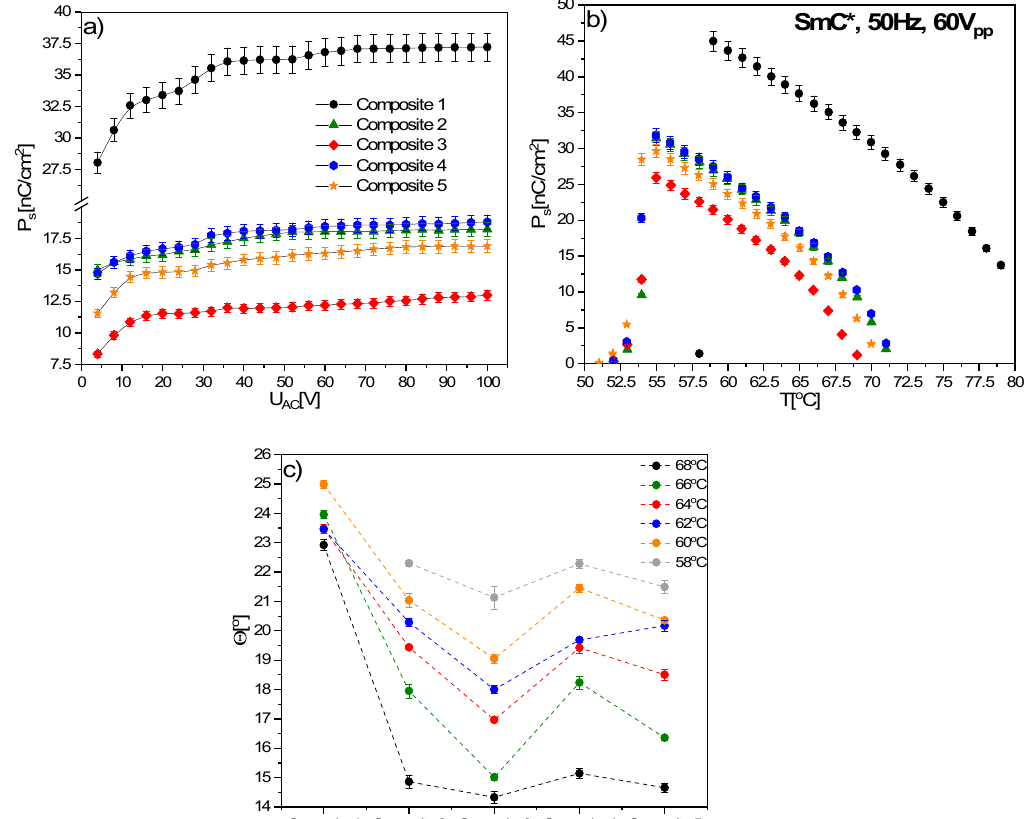
Figure 11. Spontaneous polarization versus applied voltage (50 Hz, triangular wave) in the SmC* phase (65.0 °C) for Composites 1–5 ( a ), temperature dependence of spontaneous polarization, the accuracy of the P s is 3% ( b ), and tilt angle of Composites 1–5 at several selected temperatures ( c ). Dashed lines are a guide for the eye.